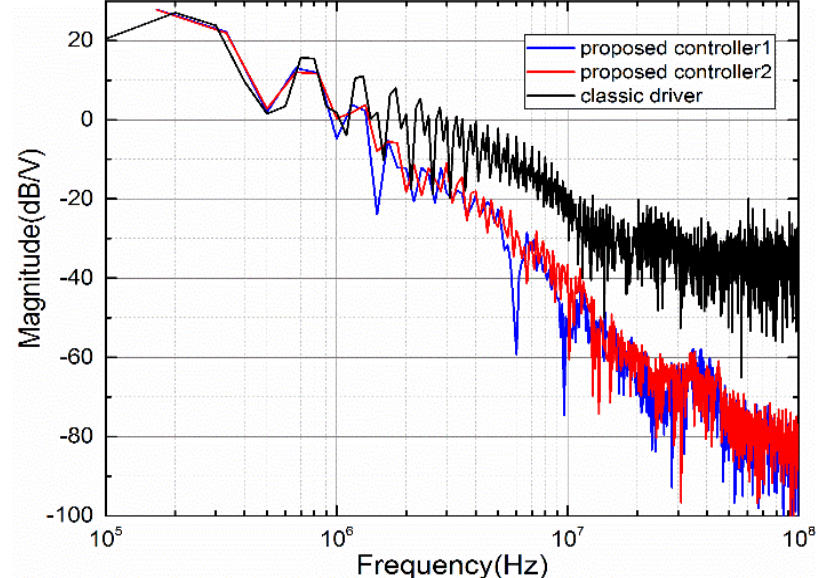
Figure 16. Spectra comparison of V ds between classic gate driver (black), proposed controller 1 (blue)